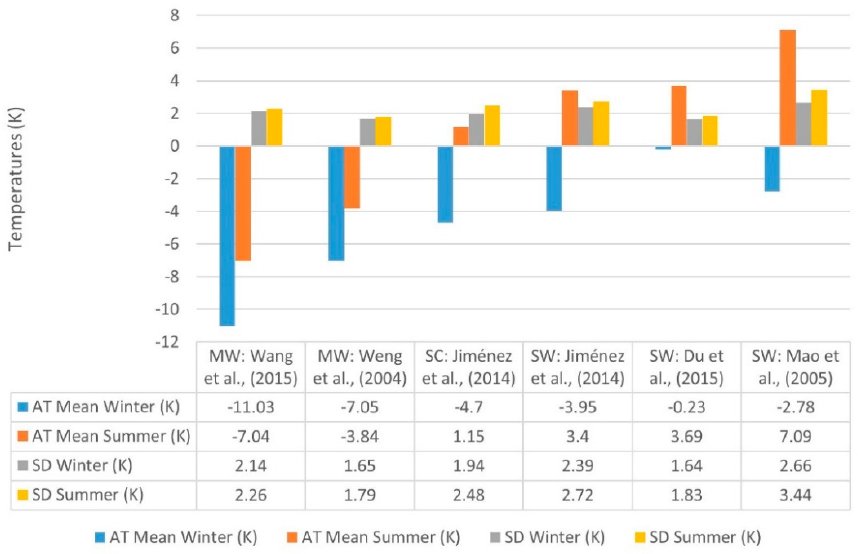
Figure 5. Comparison of LST obtained according to winter and summer periods.